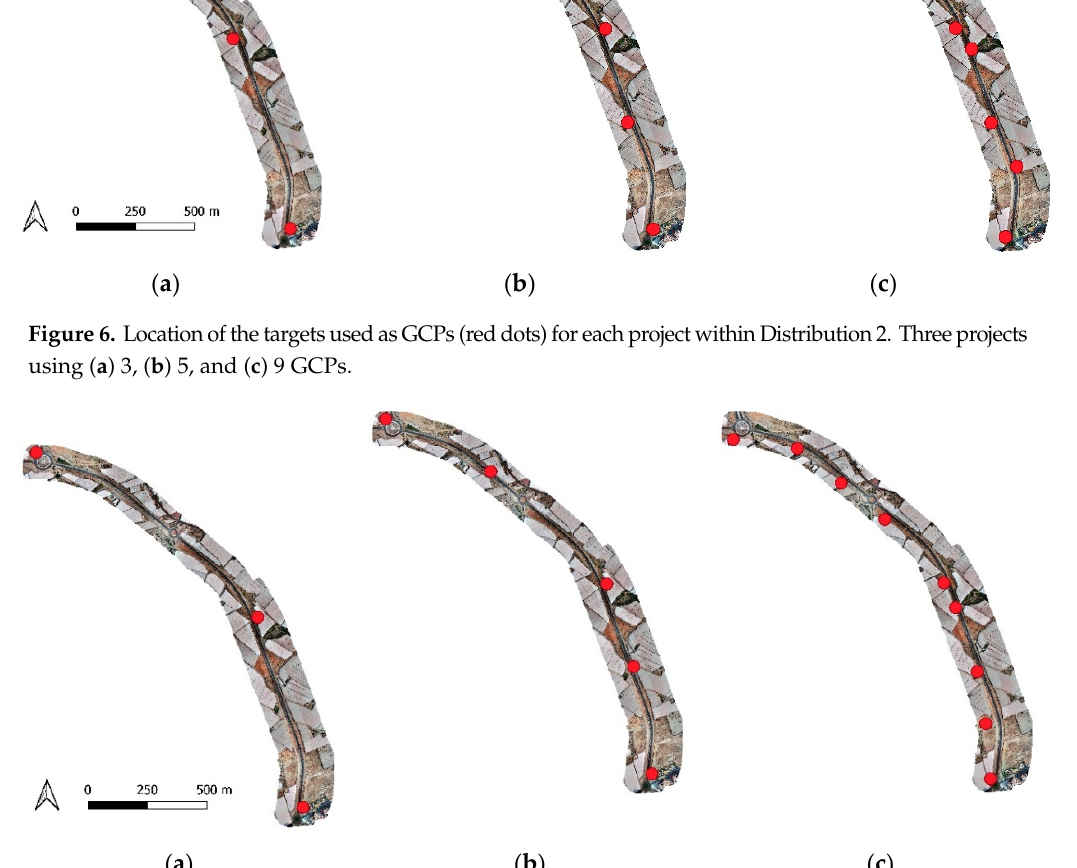
Figure 7. Location of the targets used as GCPs for each project within Distribution 3. Three projects using ( a ) 3, ( b ) 5, and ( c ) 9 GCPs. Remote Sens. 2020 , 12 , x